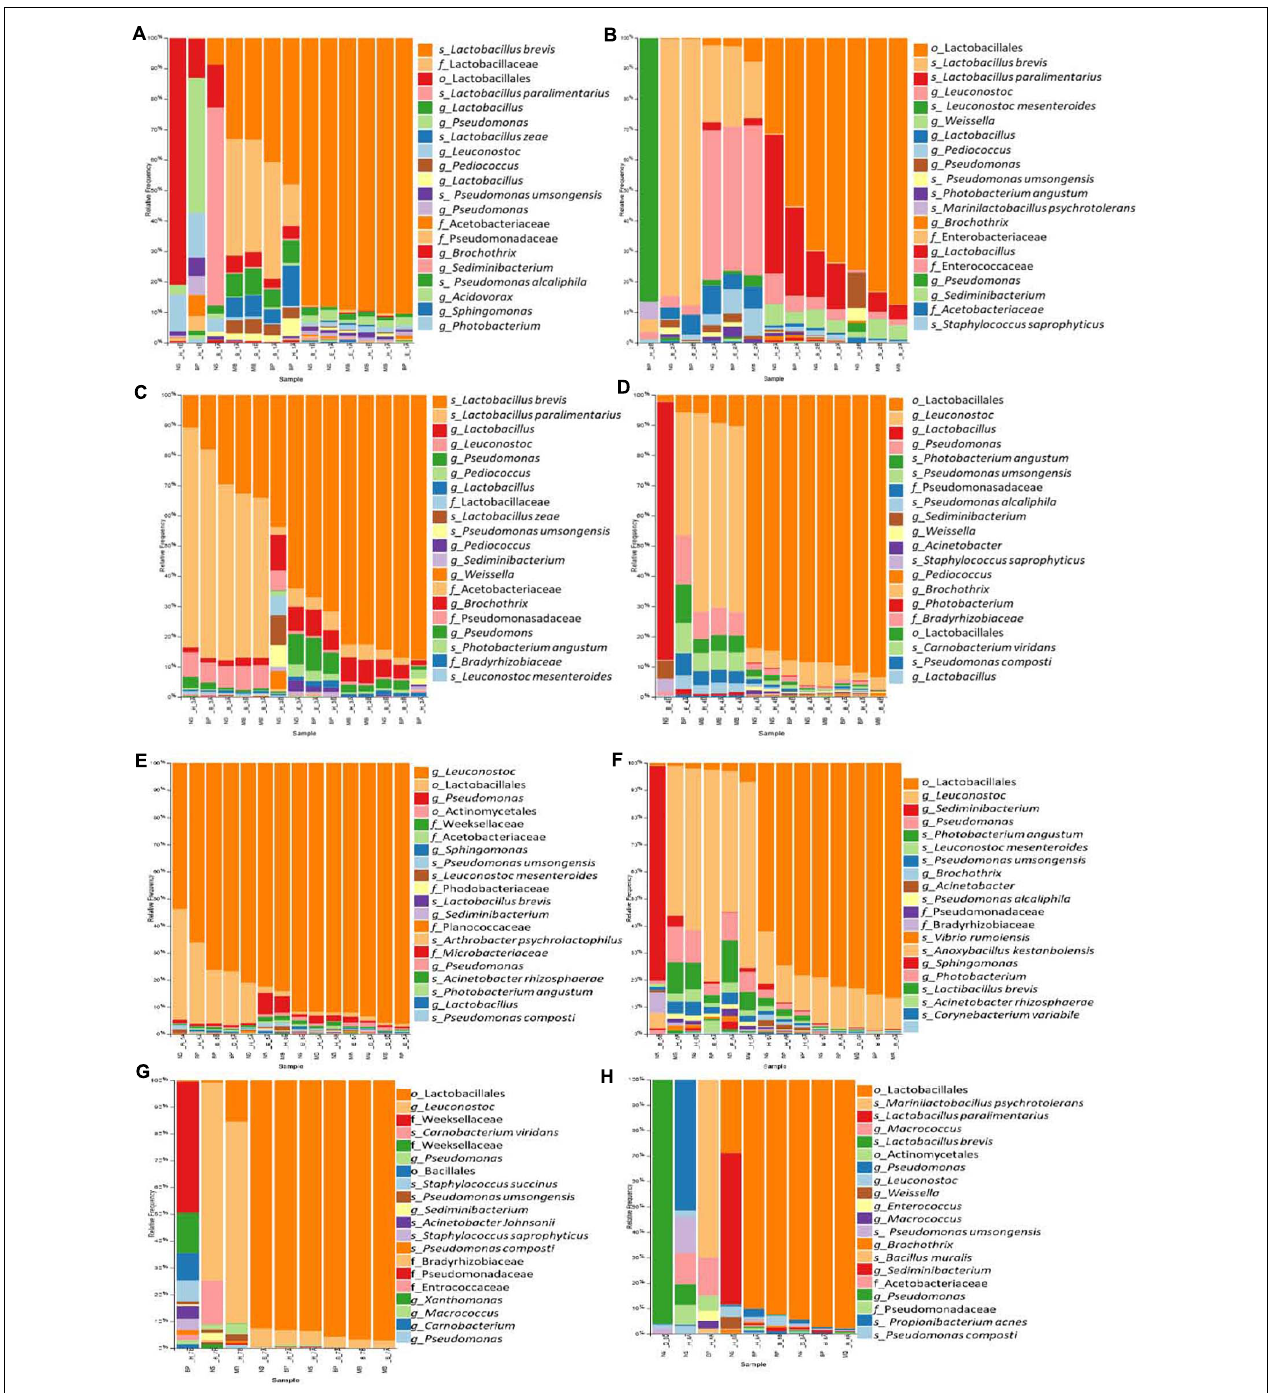
FIGURE 6 | The relative abundance of the 20 most abundant bacteria identified at the species level based on 16S rDNA sequencing for the sausages: 1 (A) , 2 (B) , 3 (C) , 4 (D) , 5 (E) , 6 (F) , 7 (G) , and 8 (H) . Abbreviations for the samples are given in Table 1 .